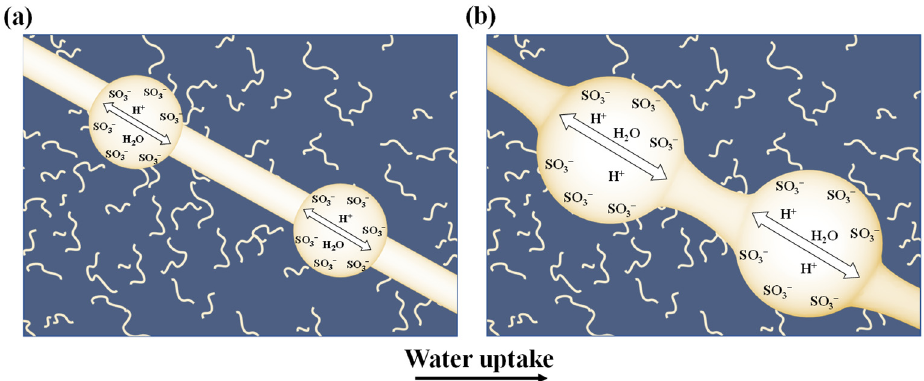
Figure 6. Proton transport mechanism diagram with proton channels for ( a ) N212 and ( b ) RM.